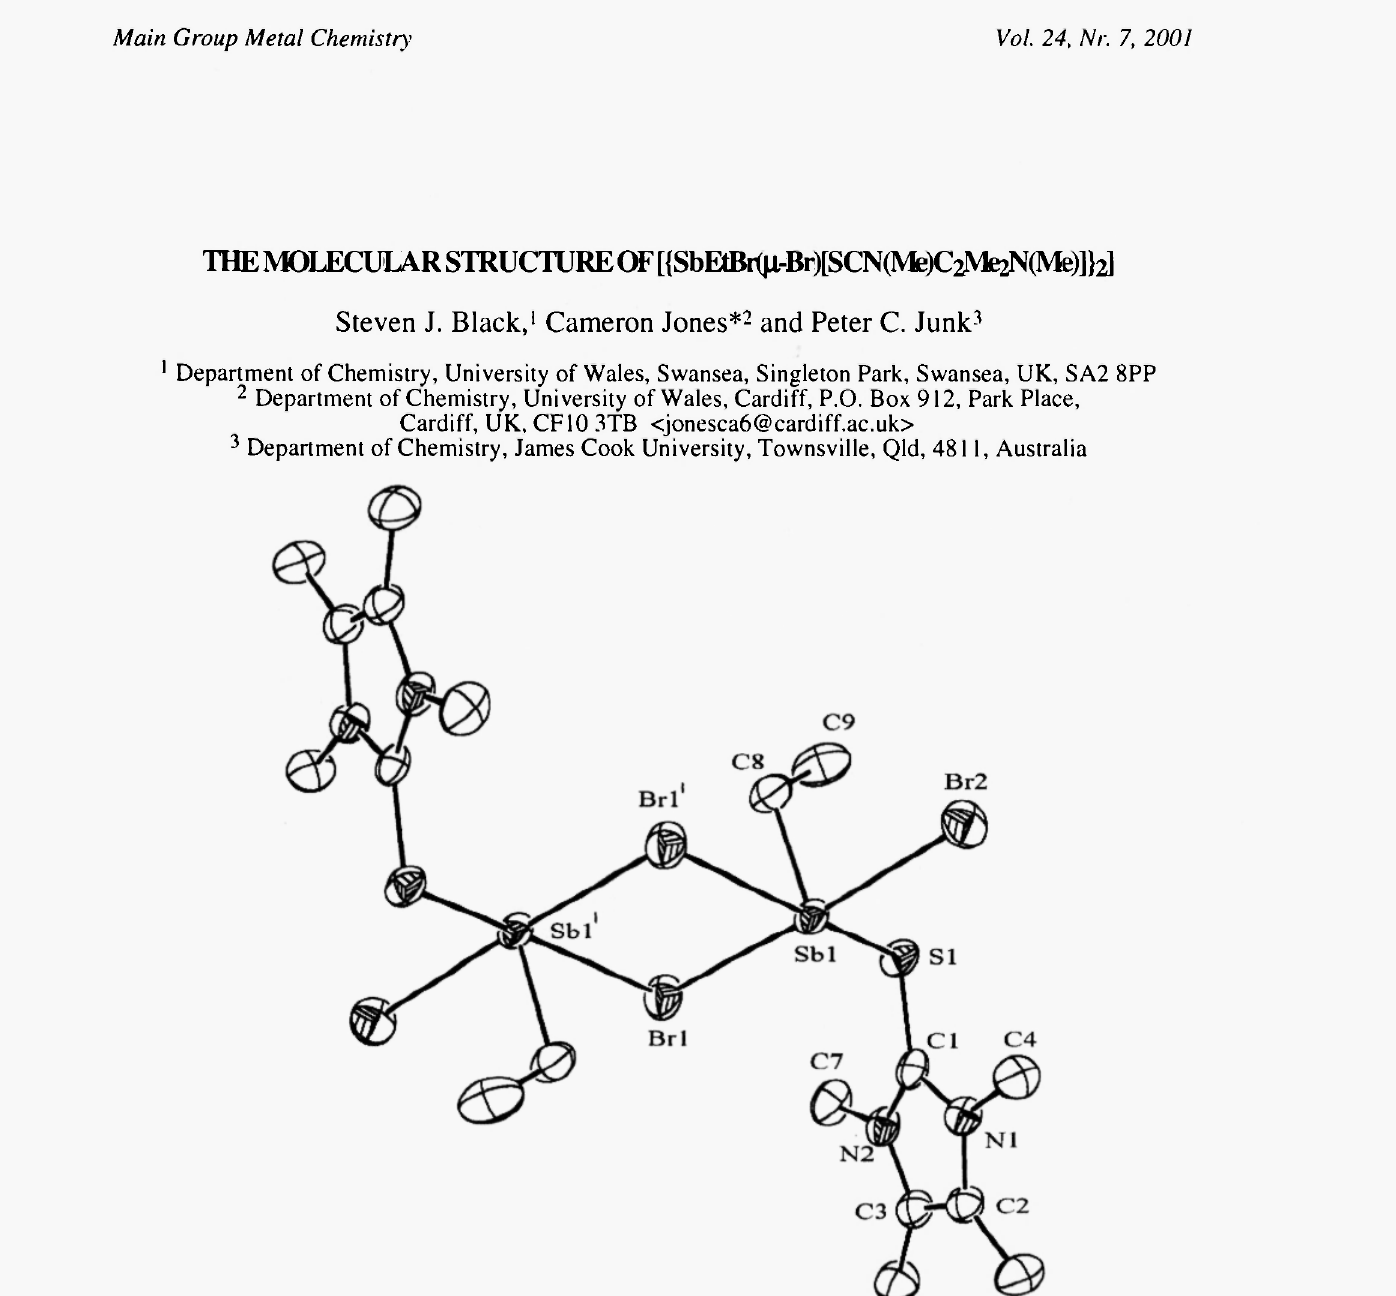
Figure 1. Molecular structure of [{SbEtBr^-Br)[SCN(Me)C2Me2N(Me)])2]· Selected bond lengths (A) and angles(°): Sb(l)-C(8) 2.166(5), Sb(l)-S(l) 2.531(1), Sb(l)-Br(2) 2.7286(9), Sb(l)-Br(l) 2.8554(9), Sb(l)-Br(l)' 3.227(1), S(l)-C(l) 1.721(5), N(l)-C(l) 1.342(6), N(2)-C(l) 1.335(6), N(l)-C(2) 1.390(6), N(2)-C(3) 1.387(6), C(2)-C(3) 1.353(7), C(8)-Sb(l)-S(l) 91.5(2), C(8)-Sb(l)-Br(2) 86.7 (2), S(l)-Sb(l)- Br(2) 88.14(4), C(8)-Sb(l)-Br(l) 87.8(2), S(l)-Sb(l)-Br(l) 87.41(4), Br(2)-Sb(l)-Br(l) 172.81(2), Sb( 1 )- Br(l)-Sb(l)' 93.21(4), C(l)-S(l)-Sb(l) 102.9(2). Symmetry operator used to generate equivalent atoms: 1-x, 1-y,